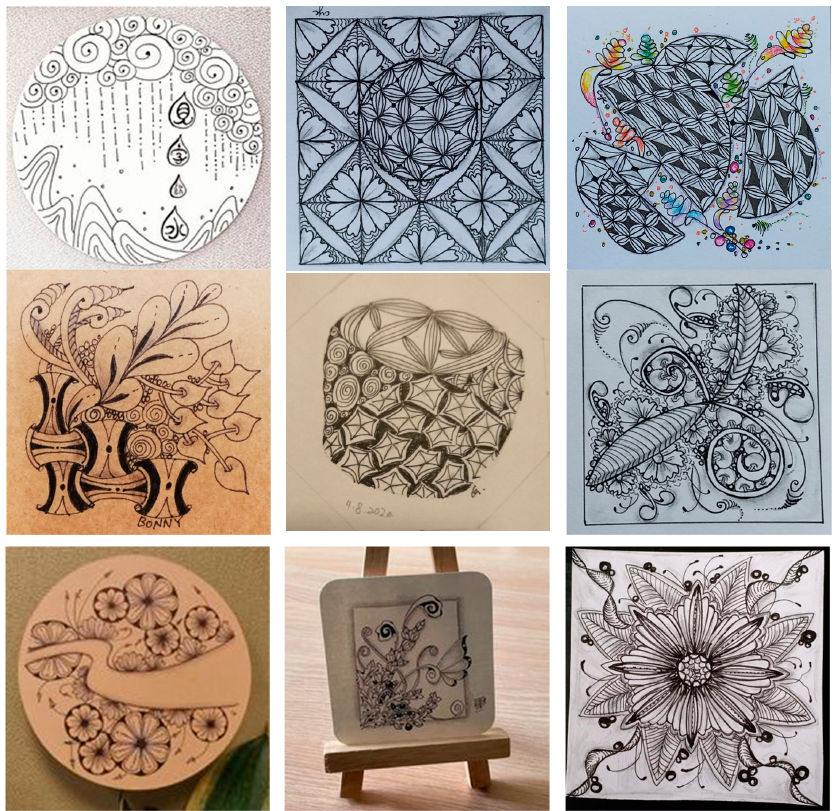
Figure A2. Participants’ Zentangle artwork posted on Caritas Aberdeen IFSC’s Facebook or the “Zen Ring” Facebook Group during September 2019 to September 2020.